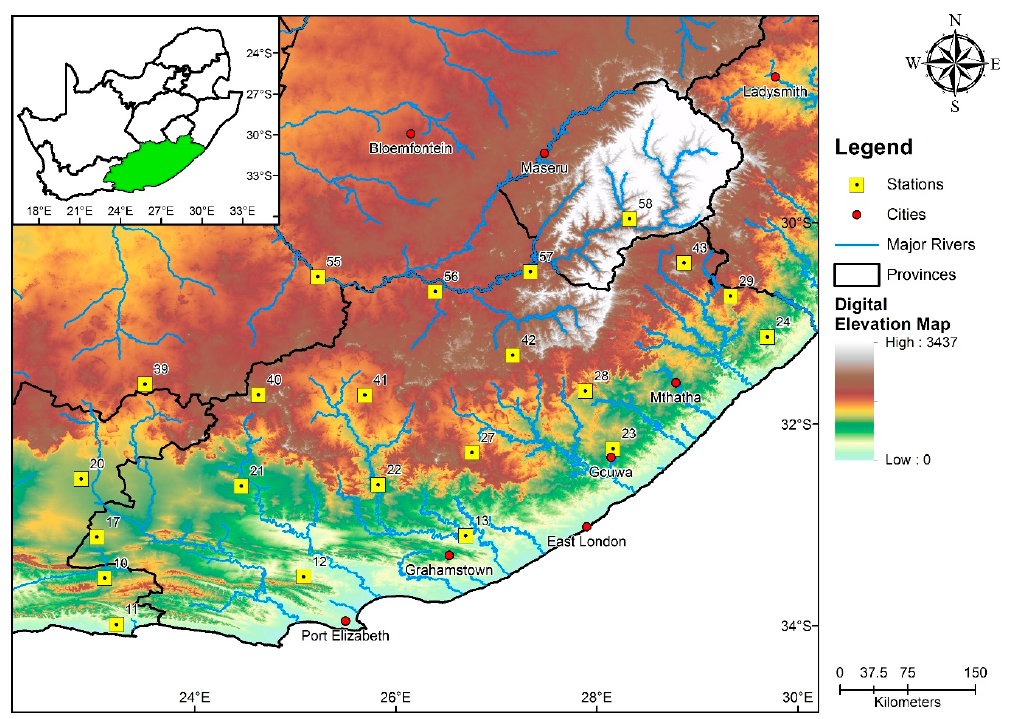
Figure 1. Eastern Cape province with the distribution of selected South African Weather Service climate district centroids and other areal characteristics.